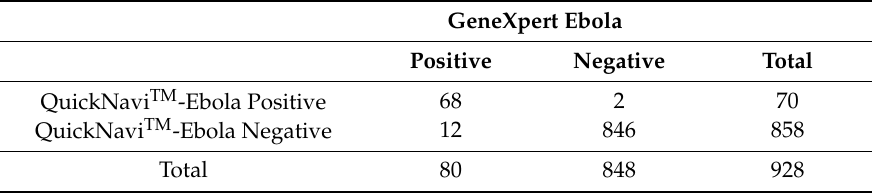
Table 2. Performance of QuickNavi TM -Ebola at the outbreak sites.